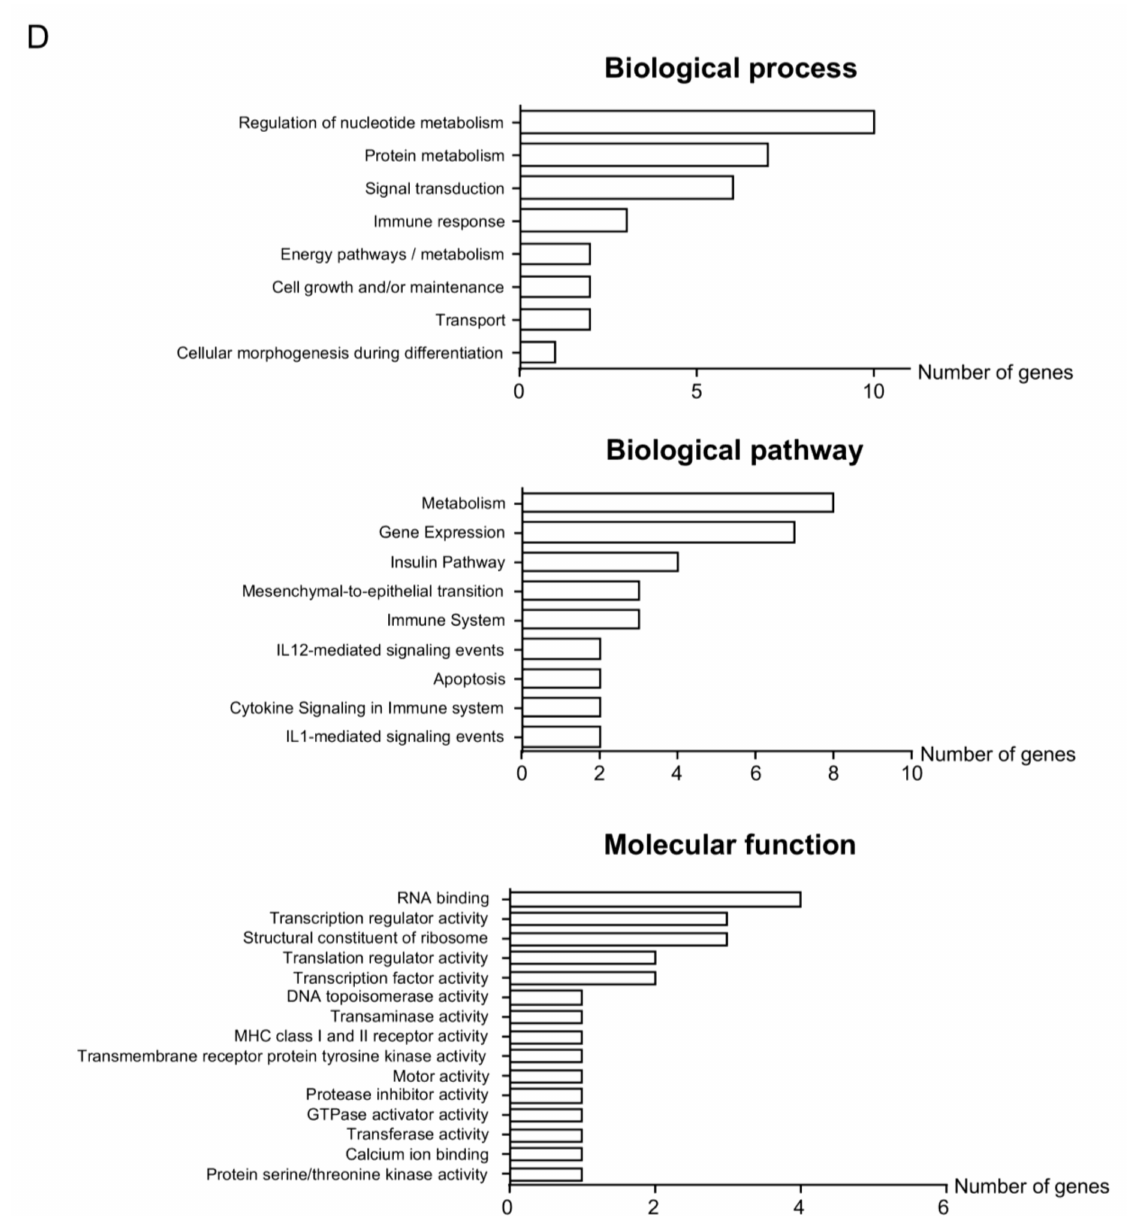
Figure 8. mRNAs commonly deregulated between urine EVs, CCA tumors from two independent cohorts of patients, tumor cells in vitro and in CCA-derived EVs. mRNAs di ff erentially abundant in serum EVs from patients with CCA vs. (PSC + UC + Healthy individuals) were compared with the transcriptome of: (i) patients with CCA from the Cancer Genome Atlas TCGA (n = 36) and “Copenhagen” (n = 217) cohorts, (ii) CCA cells (EGI1 and TFK1) and cell-derived EVs compared to their respective control groups, further selecting the ones that are commonly expressed. Heatmap of the di ff erentially expressed transcripts in ( A ) TCGA (left) and “Copenhagen” cohorts (right); ( B ) Whole-cell extracts from CCA cells and normal human cholangiocytes (NHCs); ( C ) Cell-derived EVs; ( D ) Gene ontology (GO: FunRich database [27]) analysis of the 105 transcripts commonly altered in serum EVs, CCA human tumors, CCA cells and in cell-derived EVs, highlighting the biological processes and pathways in which the identified transcripts are involved, as well as their biological function. Abbreviations: EVs, extracellular vesicles; NHC, normal human cholangiocyte; SL, surrounding liver; TCGA, the cancer genome